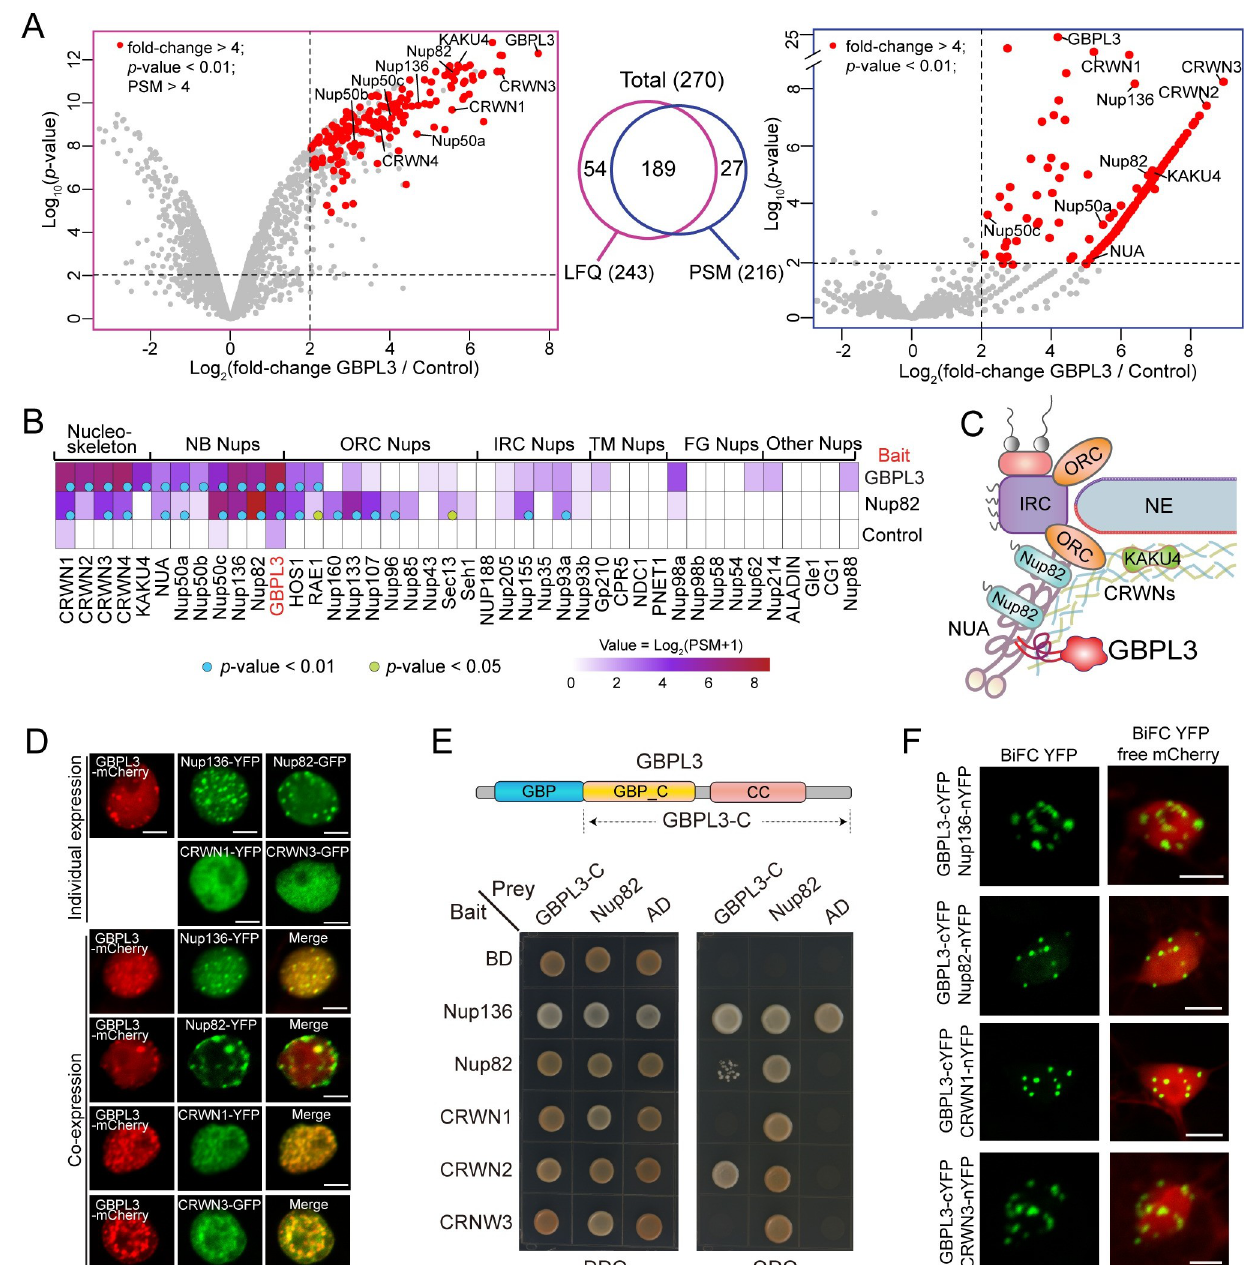
Fig 2. GBPL3 physically interacts with NPC basket and nucleoskeleton components. (A) Volcano plots of candidates identified by proximity labeling proteomics using GBPL3 as bait. Analyses based on the LFQ intensity and PSM data are shown on the left and right sides, respectively. The overlap of candidates identified by both analyses is shown in the middle. Non-transformants (WT) treated with biotin were used as control, and 2 biological replicates are included in the analysis. Significantly enriched proteins were selected using PSM > 4, fold-change > 4, and p -value < 0.01 as cutoffs and represented by red dots. The nuclear basket and nucleoskeleton components were text labeled. Underlying data can be found in S5 Data. (B) Heatmap showing normalized and averaged PSM values of all nucleoskeleton and nucleoporin proteins identified by GBPL3, Nup82, and KAKU4 using proximity labeling proteomics. Blue and green dots indicate p -value < 0.01 and 0.05, respectively. Nup82 and KAKU4 data were retrieved from PXD015919 and PXD026924, respectively. (C) A model diagram showing that the nuclear basket and the nucleoskeleton comprise a protein meshwork underneath the NPC and the position of GBPL3 at a more distal region of the NB. (D) Transient protein expression of GBPL3 and NPC basket components Nup136/ Nup82 and nucleoskeleton components CRWN1/CRWN3 in N . benthamiana . The upper 2 panels show individual protein expression, and the lower 4 panels show mCherry-GBPL3 coexpression with CRWN1-YFP, CRWN3-GFP, Nup136-YFP, or Nup82-GFP. Bars = 10 μ m. (E) Yeast-two-hybrid analysis using GBPL3-C (GBP_C domain and IDRs) and Nup82 as the bait and Nup136, Nup82, CRWN1, CRWN2, CRWN3 as the prey. Zygote yeasts were